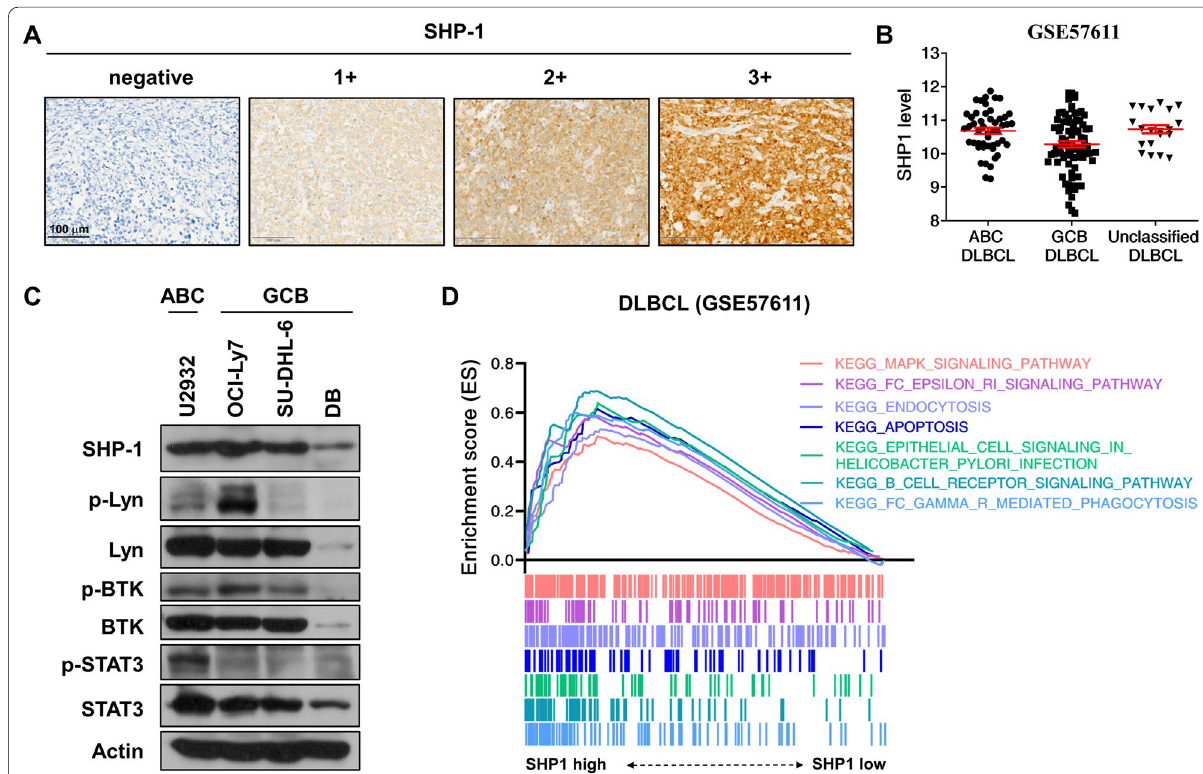
Fig. 2 SHP expression and associated pathways in DLBCL patients. A Immunohistochemistry against SHP‑1 was represented and scored (negative, 1 , 2 , and 3 ) on the DLBCL tissue microarrays (200 magnification times). B Expression of SHP‑1 transcripts in DLBCL subtypes from Gene + + + × Expression Omnibus database were analyzed. C Whole‑cell extracts of ABC DLBCL (U2932) and GCB DLBCL (OCI‑Ly7, SU‑DHL‑6, and DB) cells were analyzed by Western blot analysis. D GSEA results showing the top 7 positive enrichment terms of the KEGG pathway gene sets